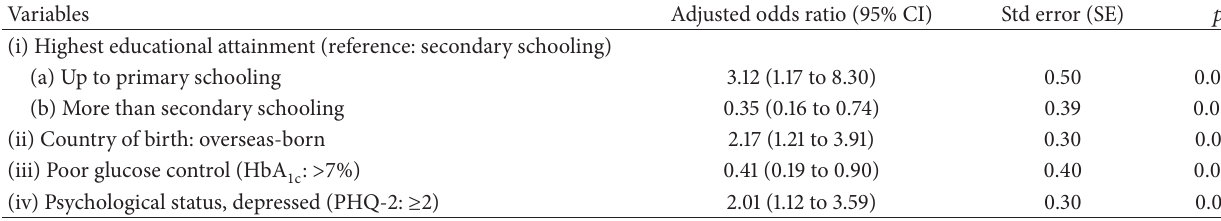
Table 3: Predictors of low health literacy in T2DM patients ( 𝑛 = 224 ).